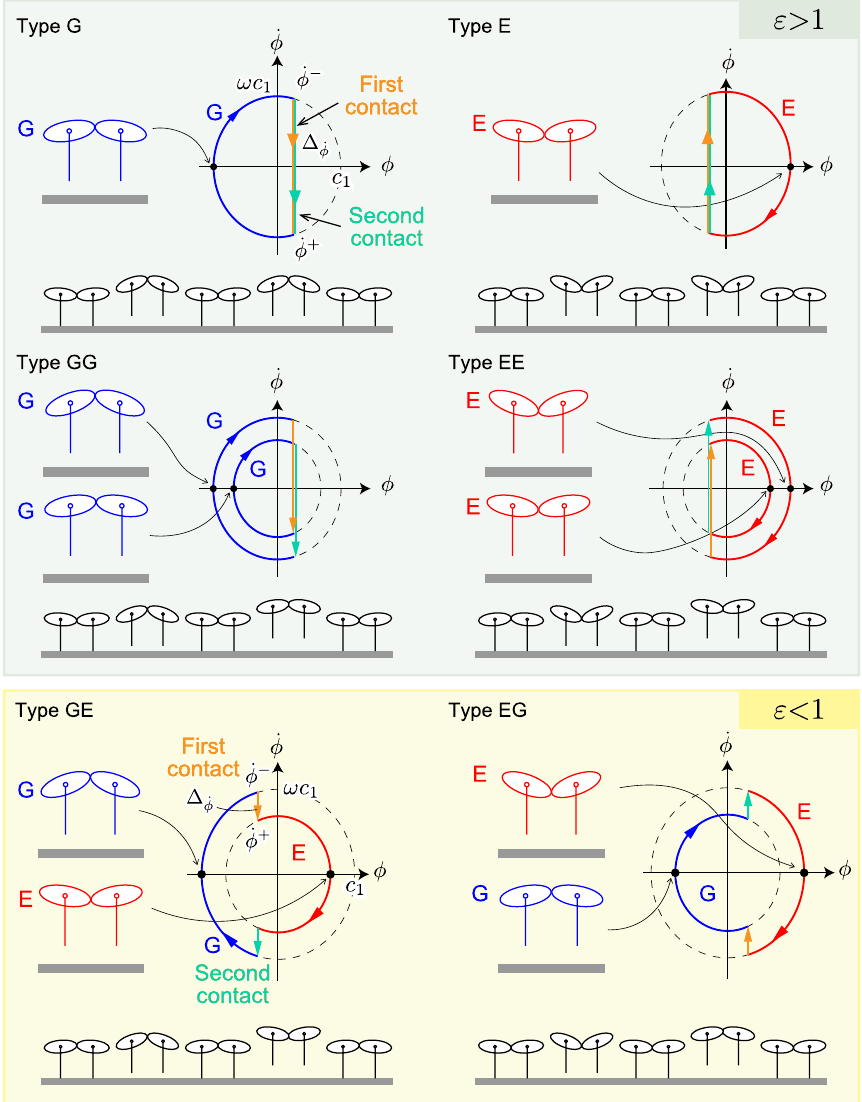
Figure 4. Phase plane of spine joint angle φ and snapshots of six types of solutions. G and E indicate gathered and extended flights, respectively. � is the difference between ˙ φ + and ˙ φ − , which indicate angular velocities ˙ φ immediately prior to and following foot contacts, respectively. ω c 1 is the amplitude of angular velocity. ε is ratio � /ω c 1 ). When ε > 1 , solutions have one type of flight (solutions of type G, of the angular velocity change ( ε = ˙ φ E, GG, and EE). Solutions of type GE and EG satisfy ε < 1